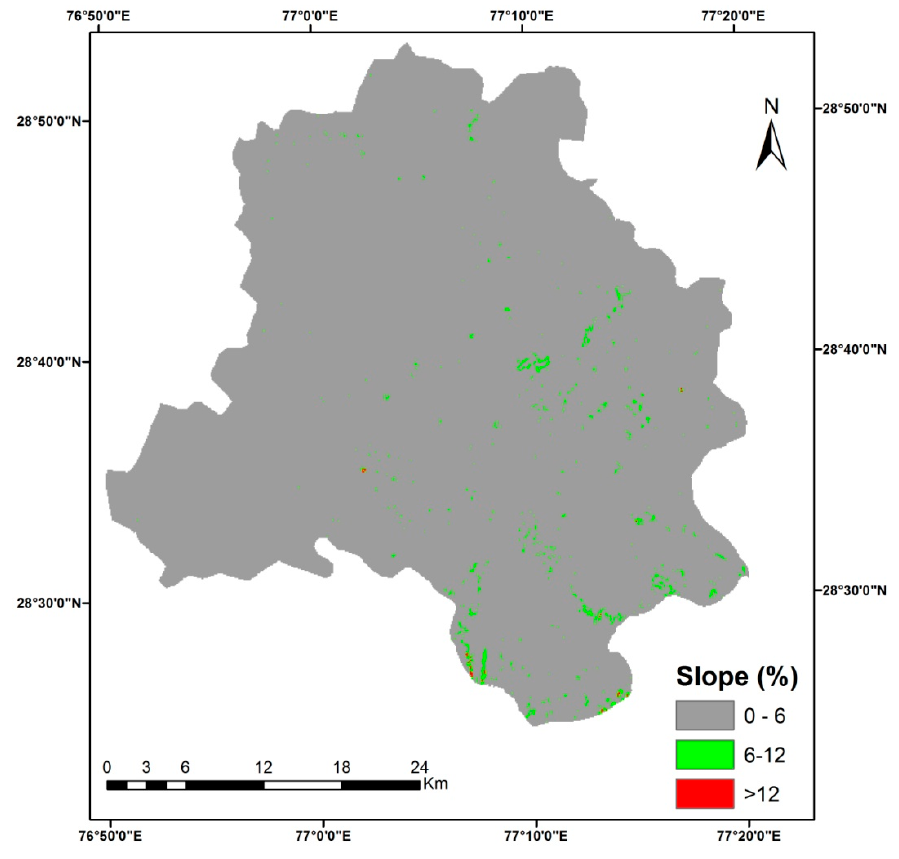
Figure 3. Slope map of the study area.